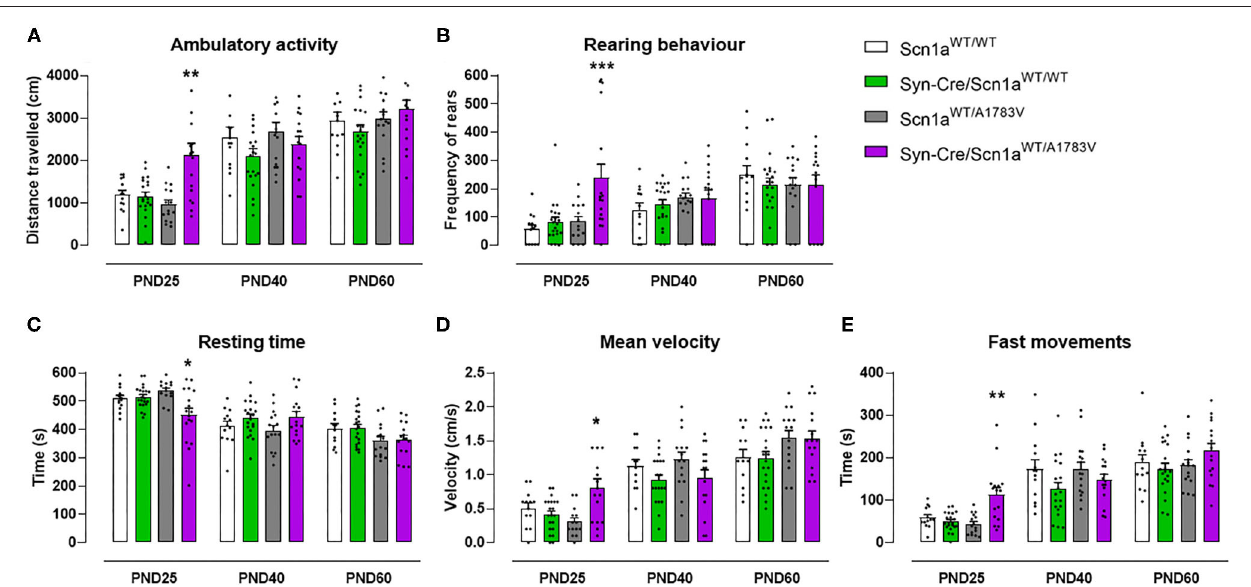
FIGURE 2 | Evolution of different behavioral parameters recorded in the computer-aided actimeter in Syn-Cre/Scn1a WT / A1783V mice and their three control groups (Scn1a WT / WT , Syn-Cre/Scn1a WT / WT , and Scn1a WT / A1783V mice) measured at different postnatal days in the range PND25–PND60. Values are means ± SEM of 13–21 animals per group. Data were assessed by using two-way ANOVA for repeated measures followed by the Bonferroni test (* p < 0.05, ** p < 0.01, *** p < 0.005 vs. the other three groups).